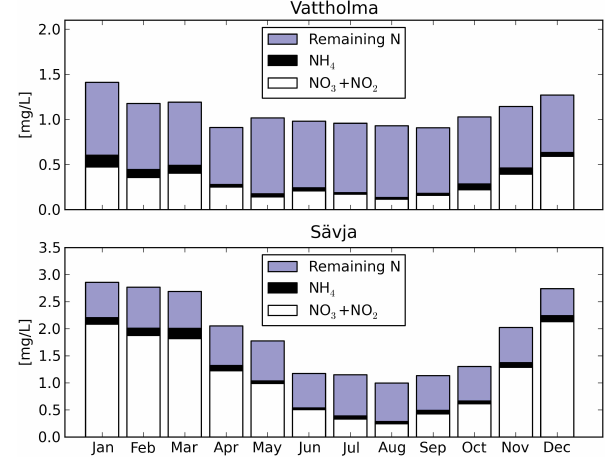
Fig. 2. Average monthly concentrations of Tot-N measured at the Vattholma and S¨avja water quality stations. (Remaining N is the difference between Tot-N and the sum of the inorganic